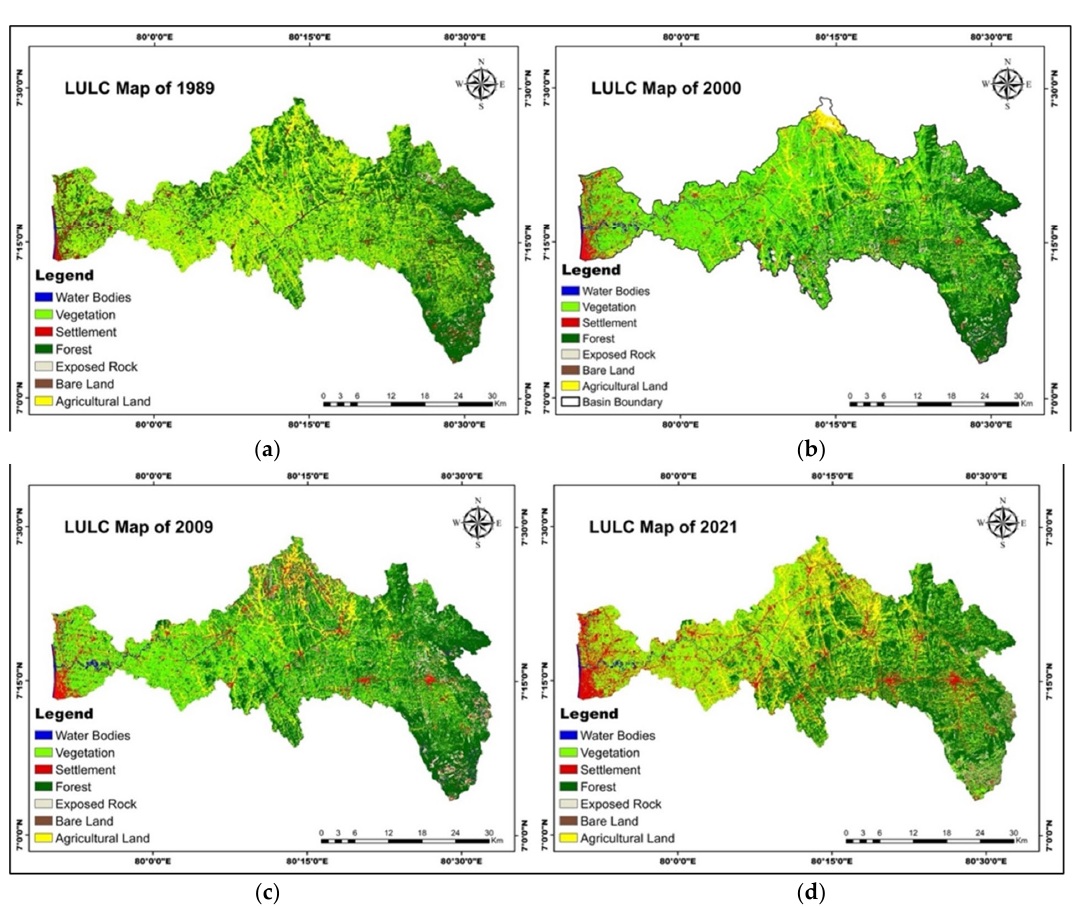
Figure 7. LU/LC maps for years ( a ) 1989, ( b ) 2000, ( c ) 2009, and ( d ) 2021.